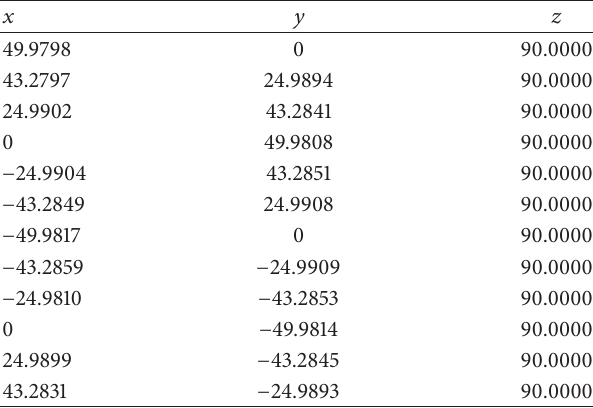
Table 3: Measuring points on section 3 (/mm).